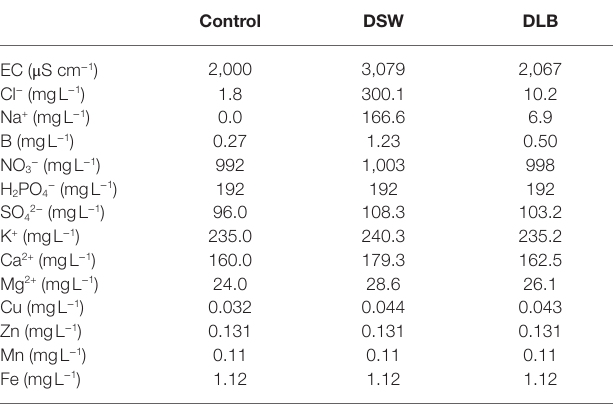
TABLE 1 | Average ionic composition and electrical conductivity (EC) of the nutrient solutions in the Control, DSW (desalinated seawater), and DLB (desalinated seawater with low boron) treatments used for irrigation during the